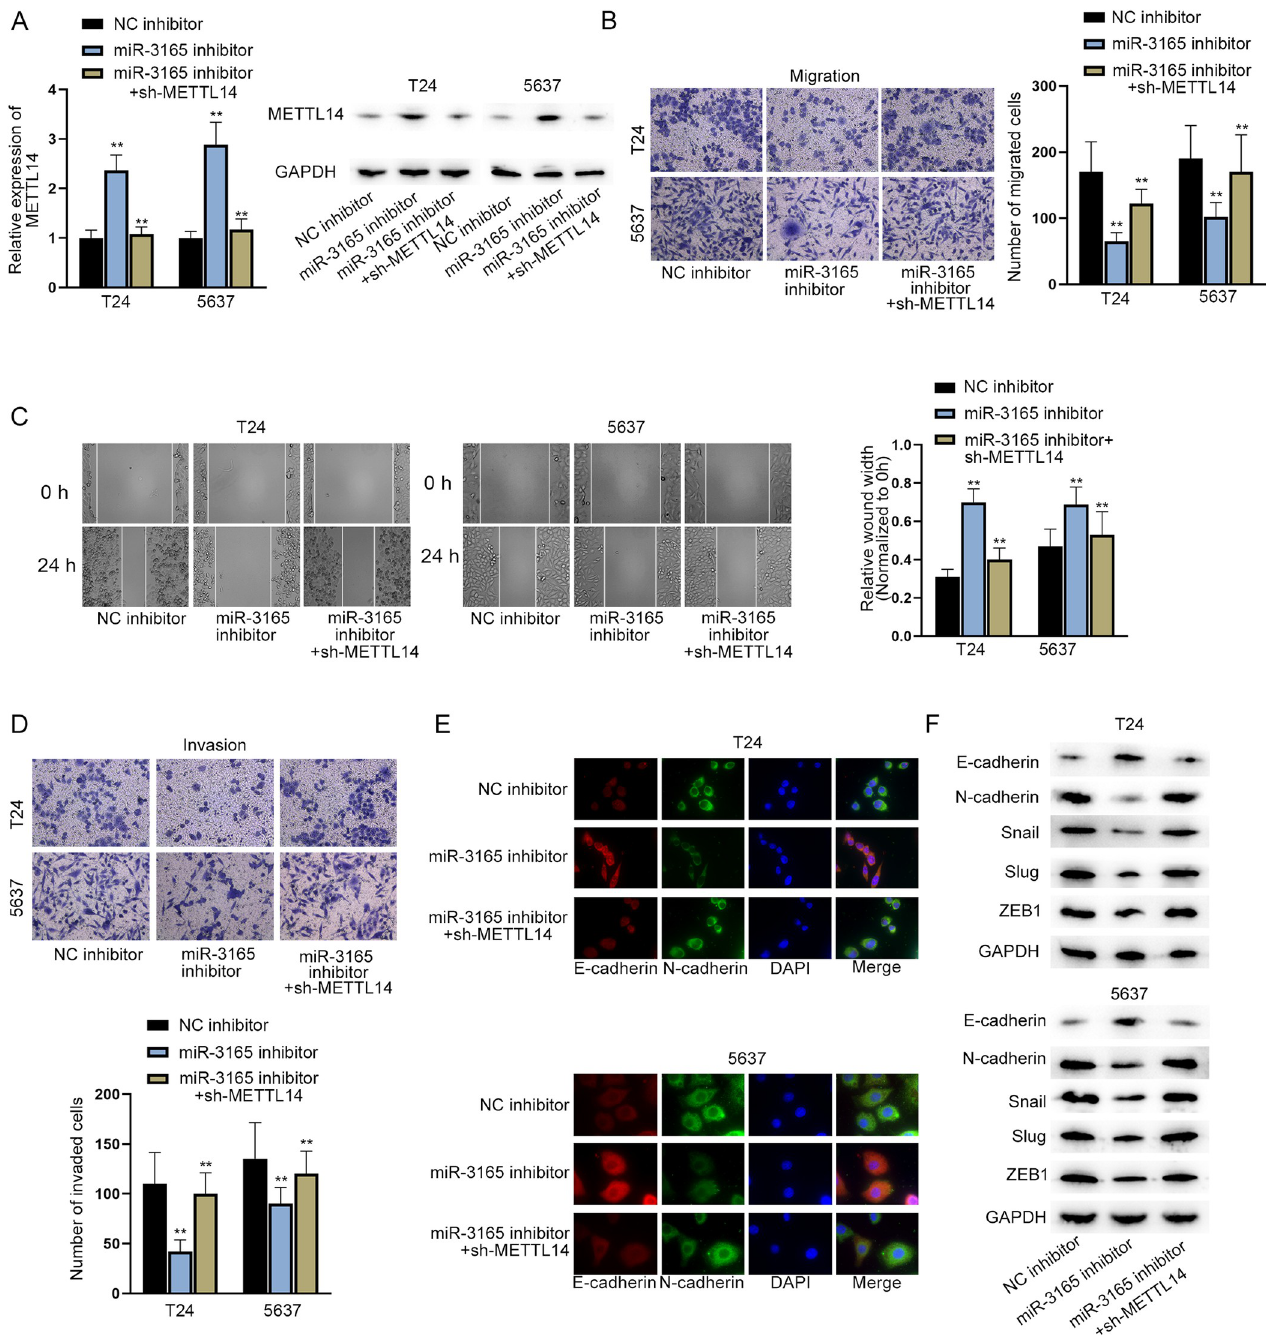
Fig 7. MiR-3165 inhibits METTL14 expression to promote migration, invasion and EMT of BCa cells. A. RT-qPCR was used to measure the relative expression of METTL14 after the down-regulation of miR-3165 with or without the subsequent knockdown of METTL14 in BCa cells (left panel). (n = 3) Each bar represents mean; error bars represent SD. P values were determined by one-way ANOVA followed by Dunnett’s test. Western blot analysis of METTL14 protein levels in BCa cells with different transfections (right panels). B-C. Transwell (migration) and wound healing assays were conducted to measure the migration of BCa cells after the indicated transfection. (n = 3) Each bar represents mean; error bars represent SD. P values were determined by one-way ANOVA followed by Dunnett’s test. D. Transwell (invasion) assay was conducted to measure the invasion of BCa cells after the indicated transfection. (n = 3) Each bar represents mean; error bars represent SD. P values were determined by one-way ANOVA followed by Dunnett’s test. E. IF assay was performed to assess levels of EMT-related proteins in BCa cells after the indicated transfection. F. Western blot analysis of EMT-related proteins in BCa cells transfected with the indicated plasmids. �� P < 0.01. See also S3–S7 Data files.